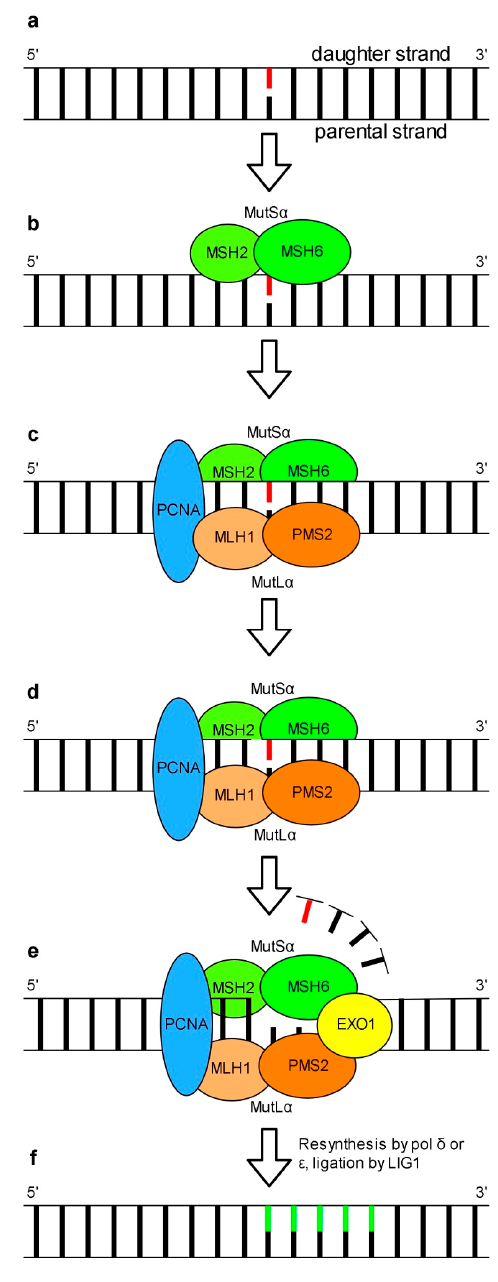
Figure 4. A scheme presenting the repair of mismatched nucleotides by MMR based on a mammalian model. A mismatched pair of nucleotides at complementary DNA strands does not create correct hydrogen bonds ( a ). The MutS α complex, composed of MSH2 and MSH6 recognizes unpaired bases ( b ). MutS α interacts with MutL α made up of MLH1 and PMS2. The MutS α -MutL α -DNA complex